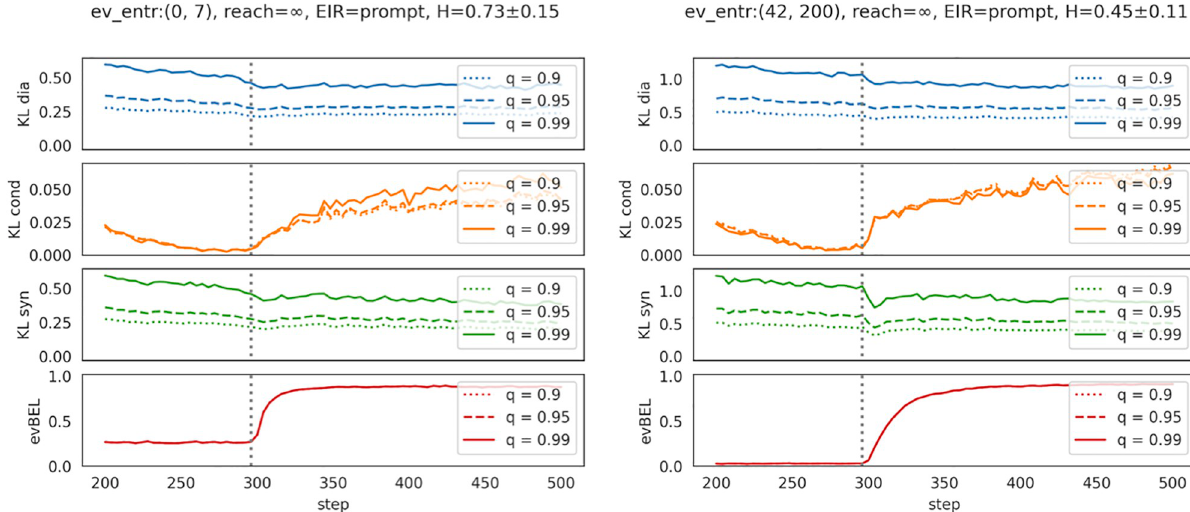
Fig 4. Evolution of Bayesian metrics. Evolution of Bayesian metrics before and after evidence introduction with evidence introduction regime prompt and inferentially closed pre-training corpora ( reach = 1 ). Left: evidence contradicts a weakly entrenched background assumption; right: evidence contradicts a strongly entrenched background